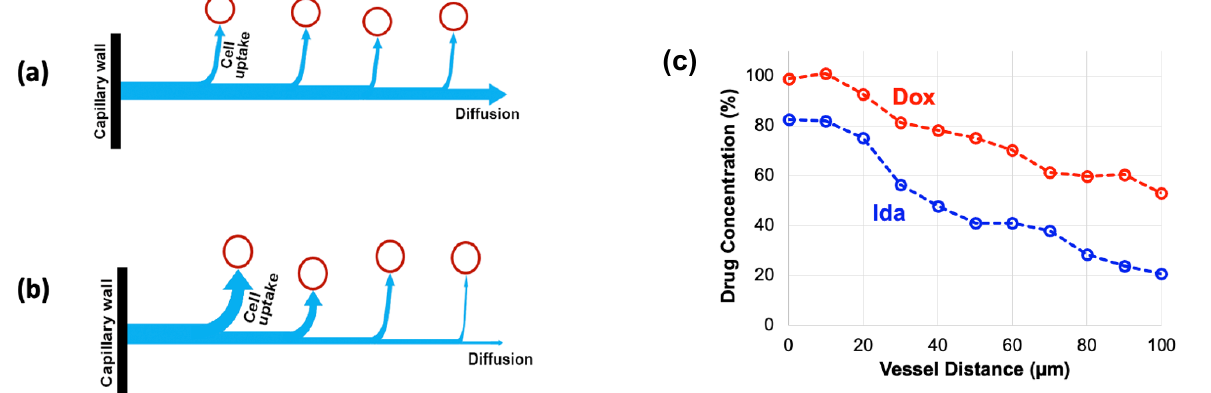
Figure 13. Rapid cell uptake produces steep radial drug concentration gradient. A competition between radial drug diffusion and cellular uptake dictates the radial drug concentration gradient. ( a ) Schematics indicating transport kinetics for a drug with slow cell uptake (e.g., DOX). Diffusion is dominating over cell uptake, allowing drug penetration distant from the capillary. Blue arrows indicate drug transport, red circles represent cancer cells. ( b ) For a drug with rapid cell uptake (e.g., ACLA, IDA), the uptake by cells close to the capillary depletes drug available for more dis- tant cells. ( c ) A prior in vivo study demonstrated a steeper radial concentration gradient for IDA (rapid uptake) compared to DOX (slower uptake), shown after 60 min hyperthermia [105]. Figures reproduced from [172] (published under CC BY